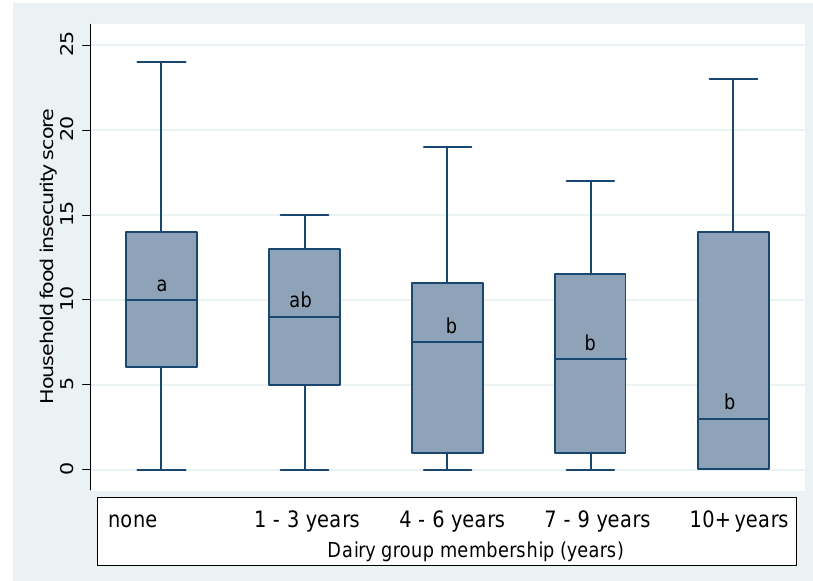
Figure 2. Household Food Insecurity Score (Median, Interquartile Range, and Range) by Dairy Group Membership